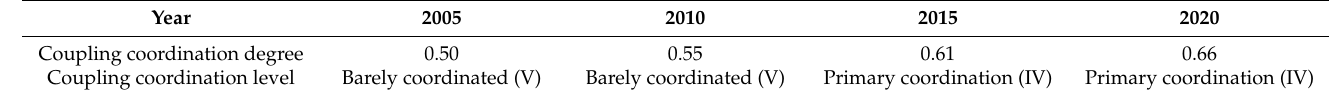
Table 8. Changes in the overall coupling coordination level of